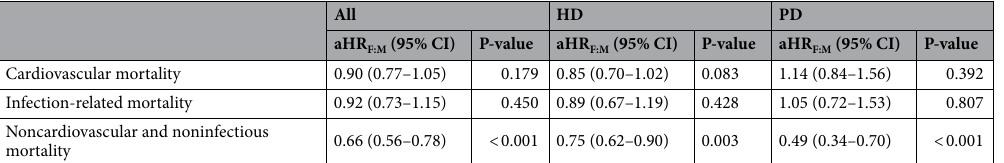
Table 4. Multivariable regression analysis of the association of sex (female versus male) according to cause- specific mortality. CI confidence interval, F female, aHR adjusted hazard ratio, HD hemodialysis, M male, PD peritoneal dialysis. Models were adjusted for age at the time of dialysis, body mass index, diabetes, cardiovascular comorbidities (coronary artery disease, cerebrovascular disease, congestive heart failure, arrhythmia, peripheral vascular disease, hypertension), chronic lung disease, moderate to severe chronic liver disease, malignancy, albumin, hemoglobin, calcium, phosphorus, subjective global assessment scores, and dialysis vintage.